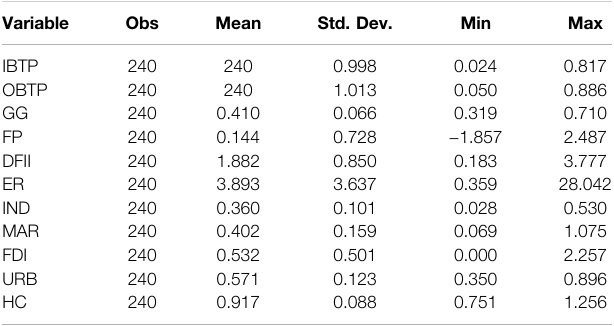
TABLE 3 | Descriptive statistics of